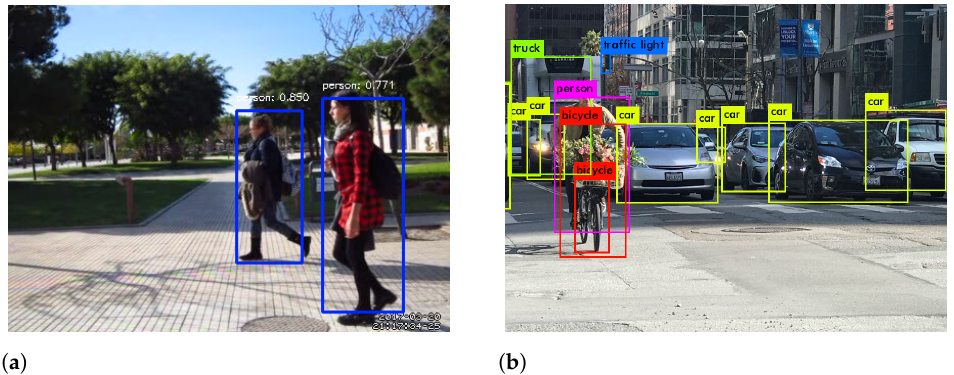
Figure 1. Object detection use cases including pedestrians and vehicles detection. ( a ) Pedestrian data set detection by YOLOv2 (image from [9]). ( b ) Object detection on the street (image from